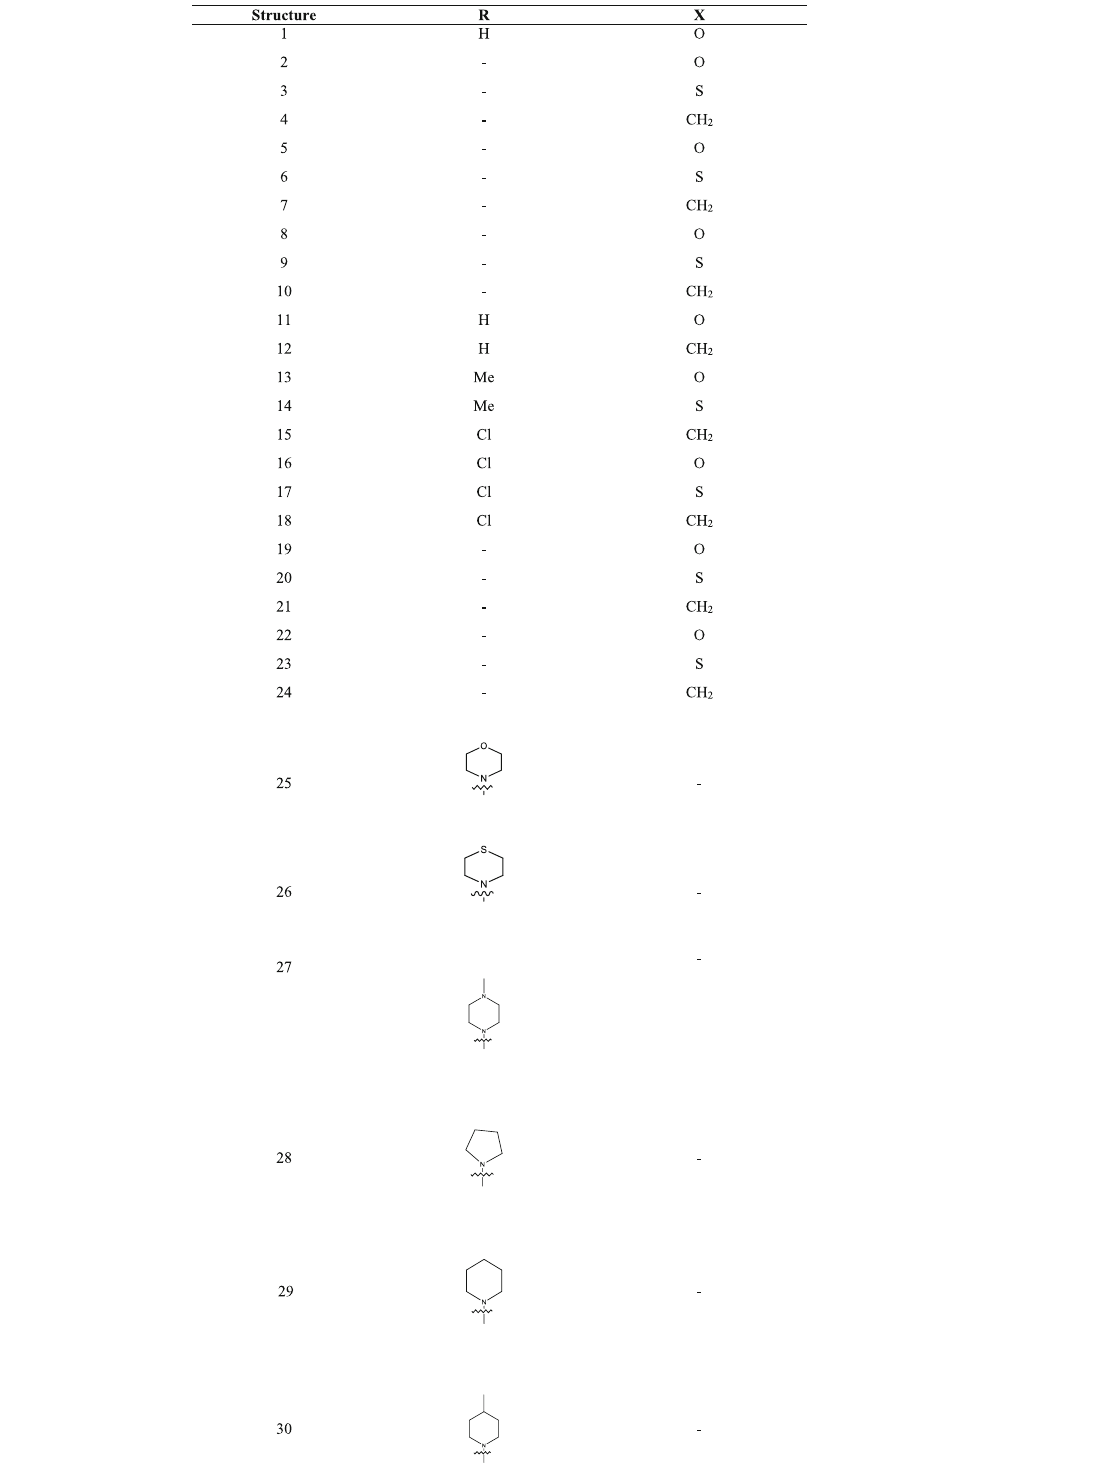
Table 1 : 2-anilimopyrimidine derivatives